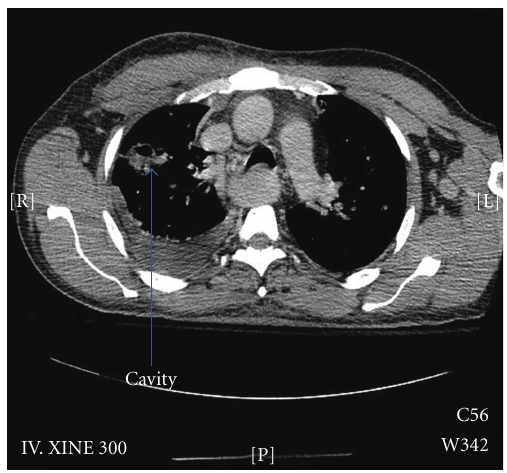
Figure 1: CT scan of the chest showing multiple abscess